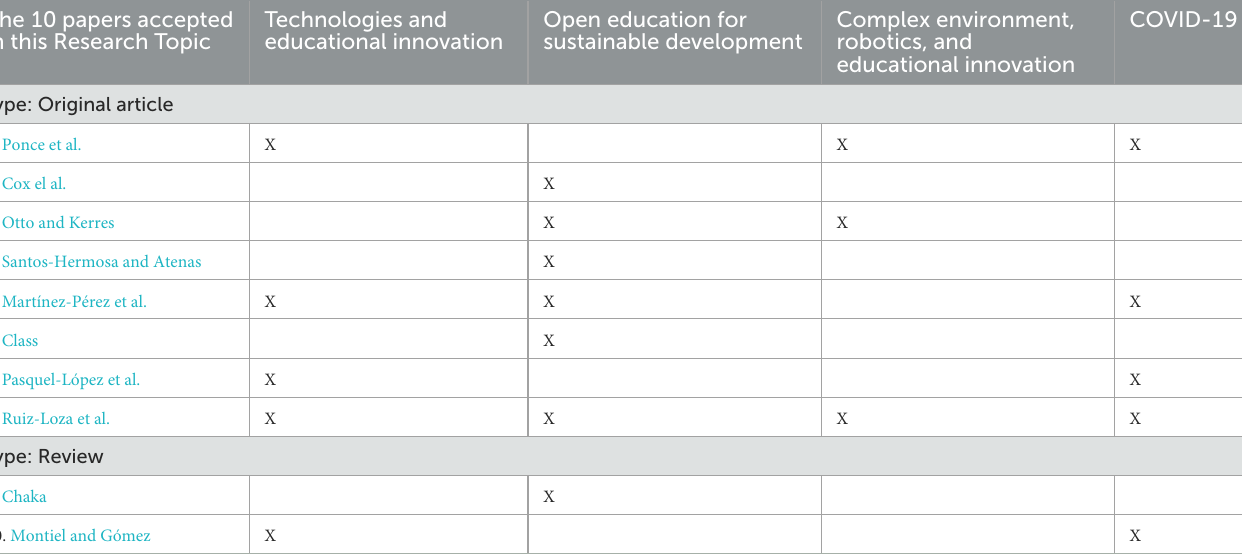
TABLE 1 Papers accepted for this Research